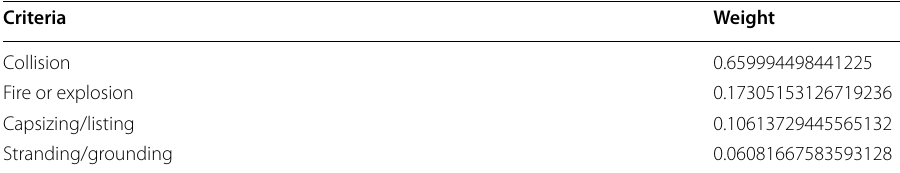
Table 4 Weight for criteria Criteria